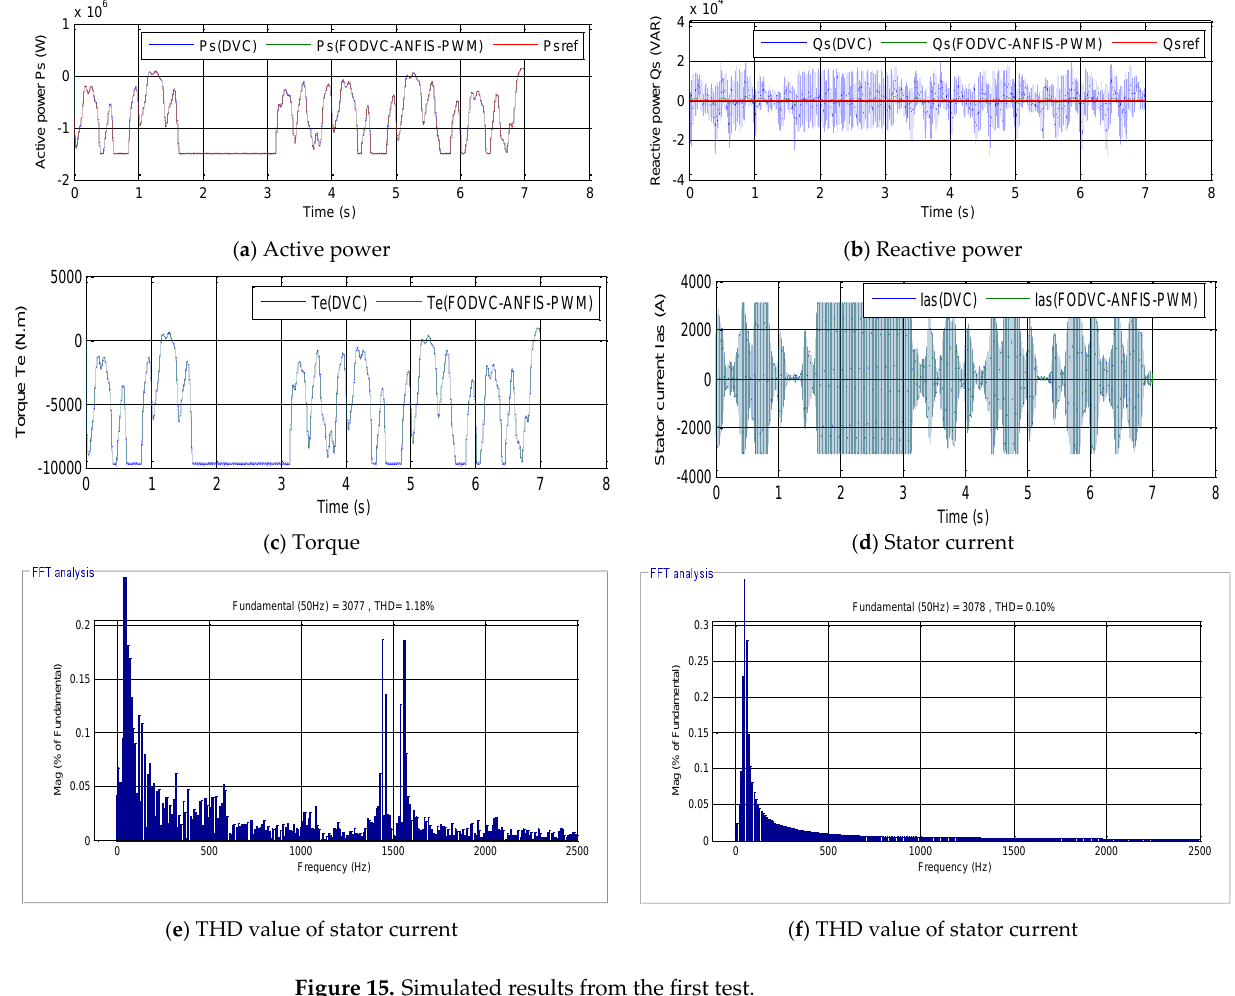
Figure 15. Simulated results from the first test. Figure 16 represents the ripples of the reactive power, torque, active power, and sta- tor current of the traditional and proposed FODVC-ANFIS-PWM strategies. In this figure, the proposed FODVC-ANFIS-PWM strategy minimizes the ripples in the torque, reactive power, stator current, and reactive power in comparison to the classical DVC strategy.